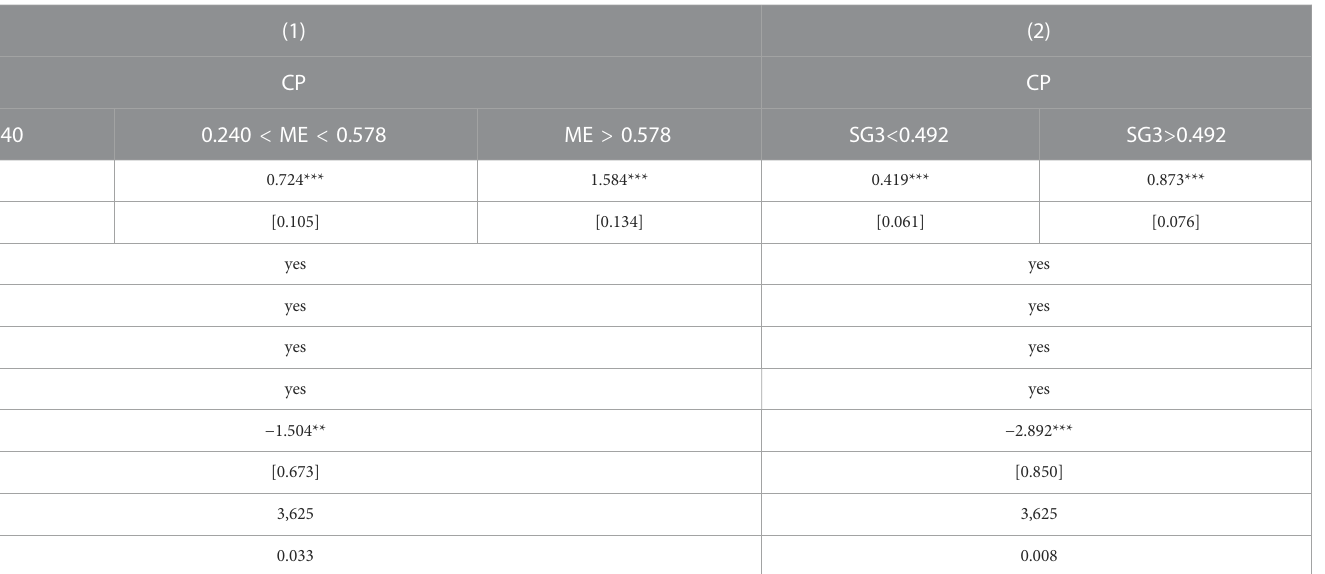
TABLE 9 Threshold